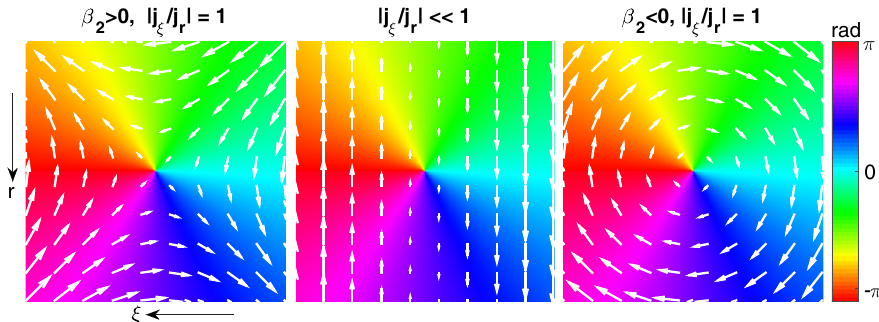
FIG. 6. Demonstration of energy flow about a þ 1 “ R -vortex ” STOV. White arrows correspond to size and direction of j in Eq. (3). There are three distinct regimes: the left-hand panel shows the saddle regime, which exists in regularly dispersive media ( β 2 > 0 ), the middle panel shows the degenerate regime, which can exist in regular or anomalously dispersive media and has a dominant axis for energy flow, and the right-hand panel shows the spiral regime, which exists in anomalously dispersive media ( β 2 < 0